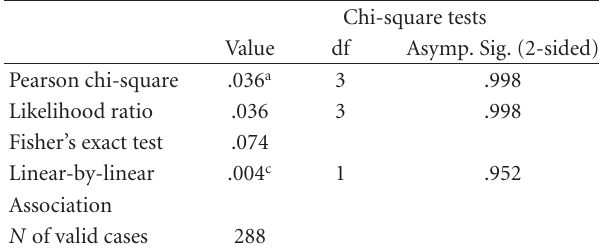
Table 3: Chi-square test to look for di ff erences in treatment plan between PA and CBCT.